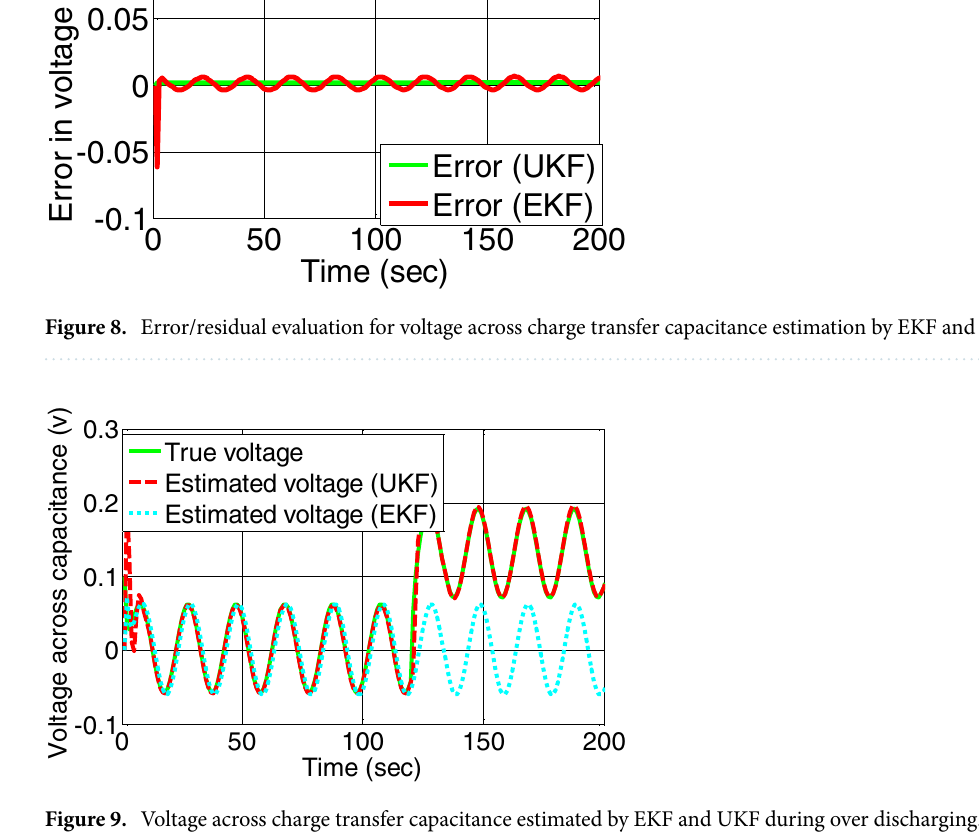
Figure 9. Voltage across charge transfer capacitance estimated by EKF and UKF during over